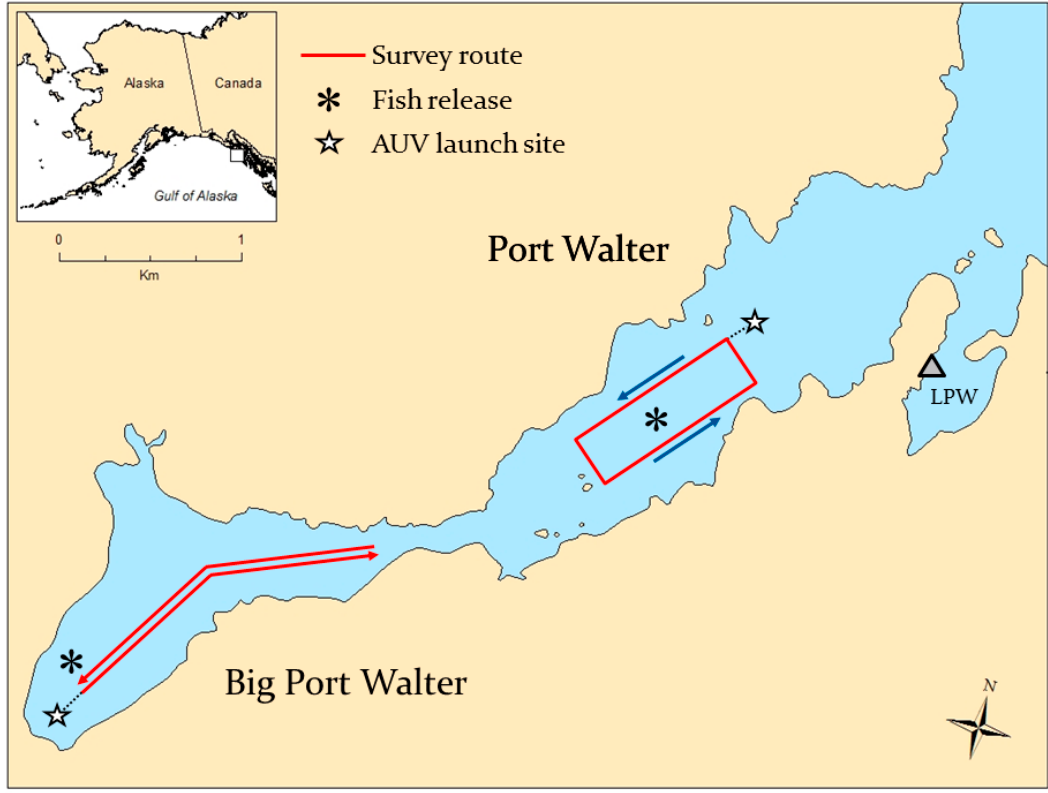
Figure 1. Map of Port Walter and Big Port Walter, Alaska, showing the survey routes used during autonomous underwater vehicle (AUV) missions and the sites where acoustically tagged juvenile Chinook salmon were released. AUV operations were based at the Little Port Walter (LPW) research station.